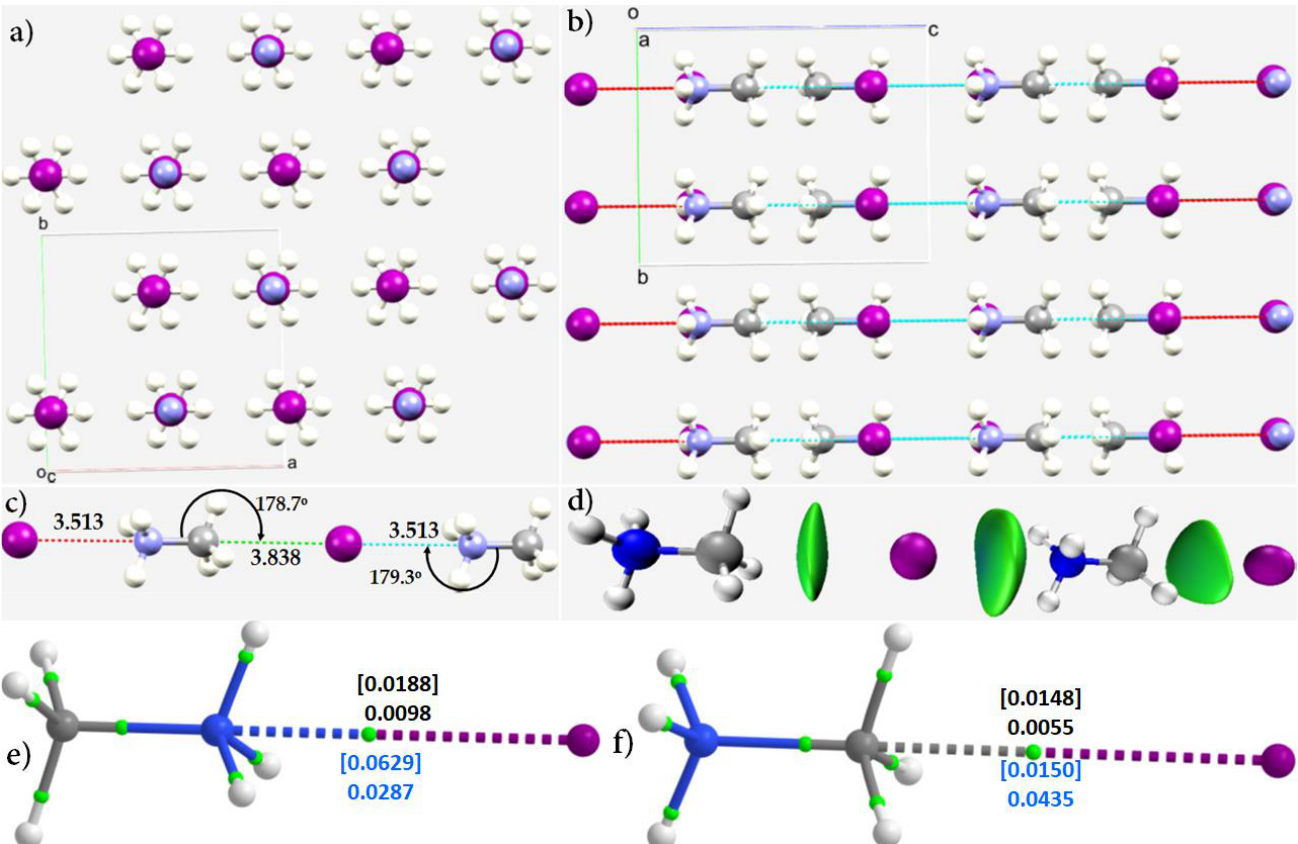
Figure 5. ( a , b ) Two different views of the ball-and-stick model of the 2 × 2 × 2 supercell structure of the crystal of perdeuteromethylammonium iodide, [CD 3 ND 3 ][I] (CSD ref: KUBNOK), with the unit- cell, together with the three crystallographic axes, shown for each case; ( c ) the nature of intermolecular bond distances and intermolecular bond angles between CD 3 ND 3+ and I − ; and ( d ) IGM- δ g based 0.004 a.u. isosurface volume (colored bluish-green) between N/C and I atomic basins of interacting units CD 3 ND 3+ and I − responsible for the structure of the crystal. ( e , f ) QTAIM based molecular graphs for H 3 C-H 3 N ··· I and H 3 N-H 3 C ··· I, respectively, obtained using ω B97X-D/def2-TZVPPD with the geometries of the same ion-pairs as in the crystal (CSD ref. KUBNOK02). Values (in a.u. ) in black and blue in ( c , d ) represent the charge density ( ρ b ) and the Laplacian of the charge density ( ∇ 2 ρ b ) at N ··· I (and C ··· I) bond critical point(s), respectively, obtained using the geometry of the adduct as in the crystal. The corresponding values calculated on the ω B97X-D/def2-TZVPPD fully relaxed geometries of H 3 C-H 3 N ··· I and H 3 N-H 3 C ··· I are shown in square brackets, respectively. Bond paths are in atom color and bond critical points between atomic basins are shown as tiny spheres in green. Bond distances and bond angles are in Å and degrees, respectively. Intermolecular contacts are colored in cyan/green and hanging contacts are colored in red. Atoms shown as balls are colored iodine—purple; nitrogen—blue; carbon—gray;